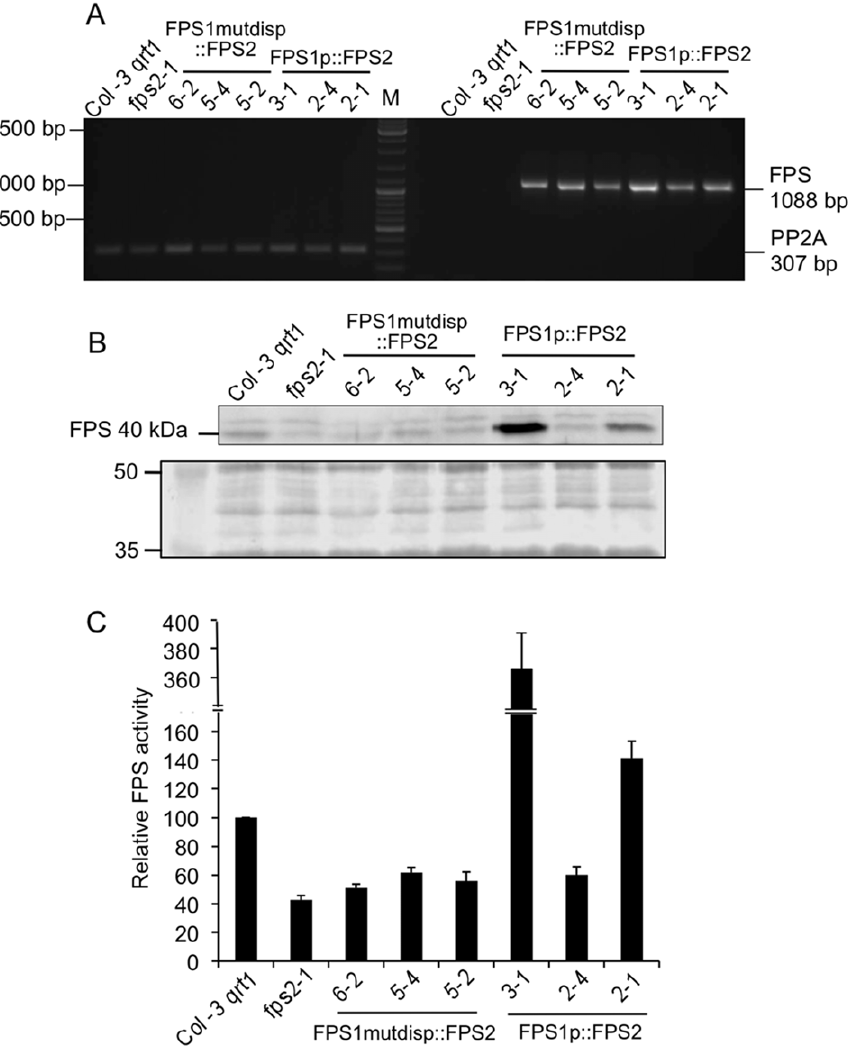
Figure 10. Characterization of fps2-1 mutant lines harbouring FPS1mutdisp::FPS2 and FPS1p::FPS2 genes. (A) The expression of FPS1mutdisp::FPS2 and FPS1p::FPS2 was investigated using total RNA from 12-day-old seedlings of Arabidopsis wild-type, fps2-1 and the indicated lines of the fps2-1 mutant harbouring FPS1mutdisp::FPS2 and FPS1p::FPS2 chimeric genes. PCR products were electrophoresed in a 1% agarose gel. The size in bp of the amplified cDNA fragments corresponding to FPS1mutdisp::FPS2 and FPS1p::FPS2 (1088 bp) and PP2A genes (307 bp) is indicated on the right. Numbers on the left indicate the sizes in bp of DNA markers shown in lane M. (B) Western blot analysis of total FPS protein in 16,000 g extracts from seeds of plant lines indicated above (upper panel). The lower panel shows the Coomassie blue-stained electrophoretic protein patterns in the 35 to 50 kDa range of extracts used for FPS protein level determinations. Images show the results of one representative experiment. (C) FPS activity in the 16,000 g protein extracts used for Western blot analysis. FPS activity in mutants is expressed relative to that in the wild-type, which was assigned a value of 100. The mean values and SE were calculated from three independent experiments.